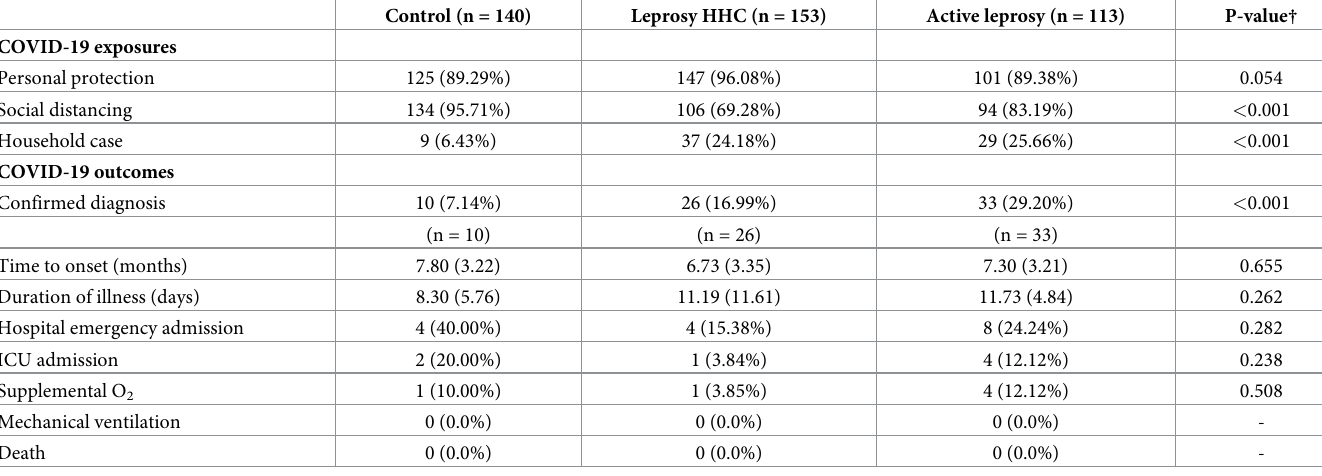
Table 1. COVID-19 exposures and outcomes in the cohort (n = 406).